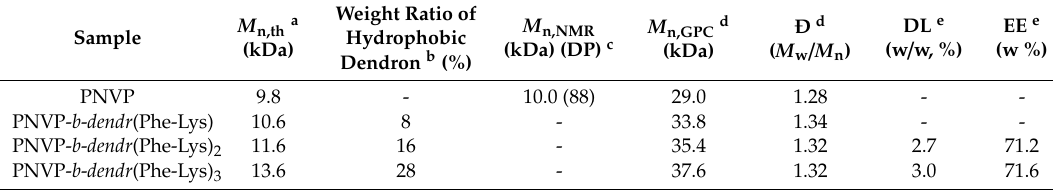
Table 1. Characterization of copolymers and their DOX-loaded